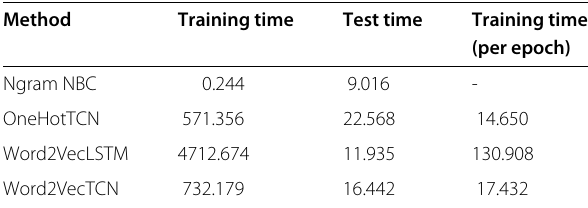
Table 4 Computing time comparisons of